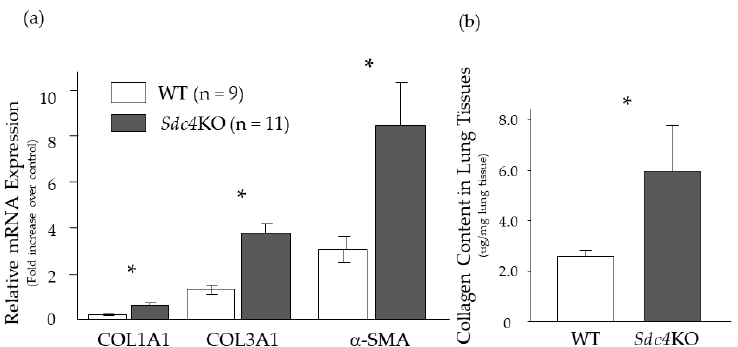
Figure 2. Pulmonary fibrosis after intratracheal bleomycin instillation. ( a ) mRNA expression of type I